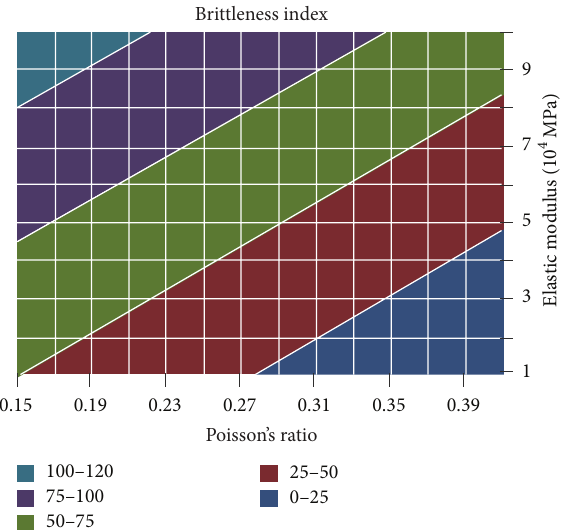
Figure 3: Relationship between rock brittle index and rock mechan- ics parameters.